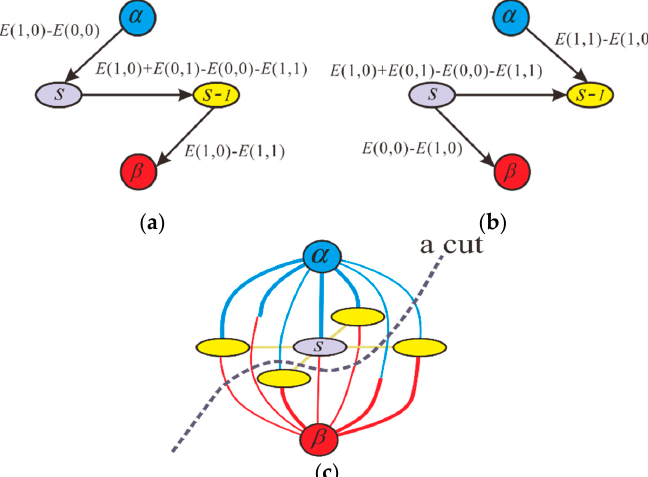
Figure 3. The elementary graph is constructed, where α and β represent two terminals and ( s , s − 1 ) represent the two neighboring pixels. ( a ) In the case of E ( 1,0 ) − E ( 0,0 ) > 0 and E ( 1,1 ) − E ( 1,0 ) > 0. ( b ) In the case of E ( 1,0 ) − E ( 0,0 ) < 0 and E ( 1,1 ) − E ( 1,0 ) < 0. ( c ) A main graph is obtained by merging the two elementary graphs, where an α − β cut is a set of edges such that the terminals are separated into two disjoint sets α ∈ 1 (the ambiguity number pluses one) and β ∈ 0 (the ambiguity number remains unchanged).